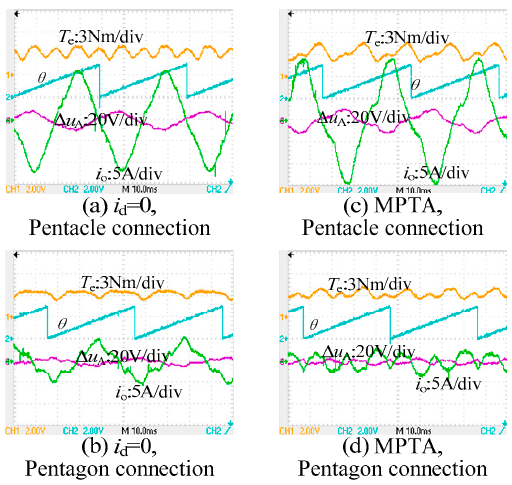
Figure 12. Waveforms of Δ u A , i o , T e , and θ under a single open-phase fault.